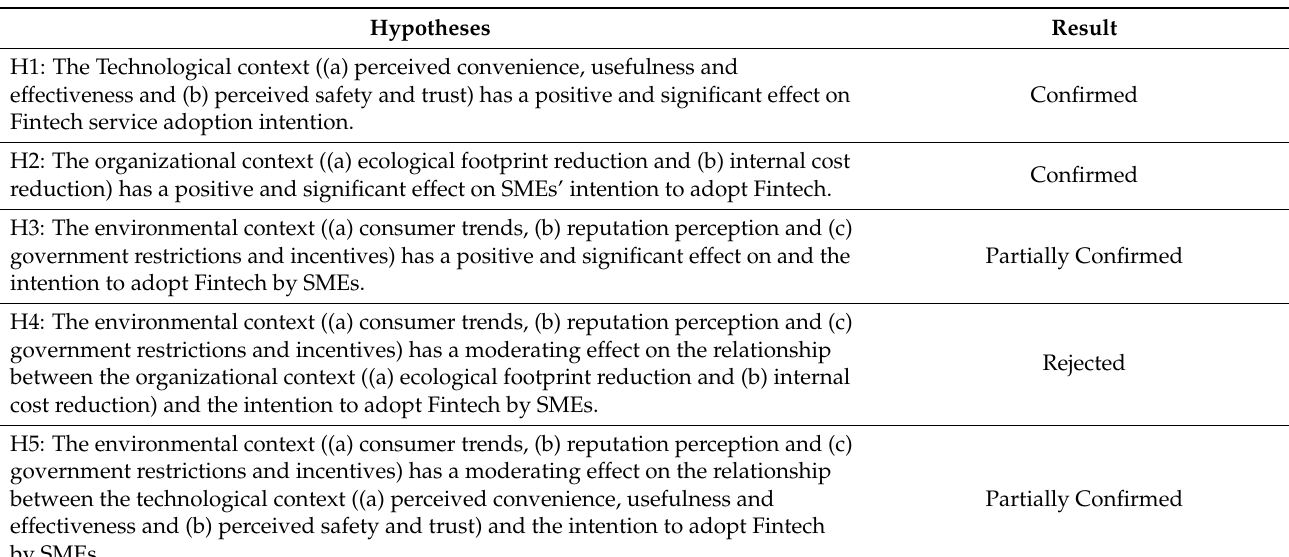
Table 12. Results of the Presented